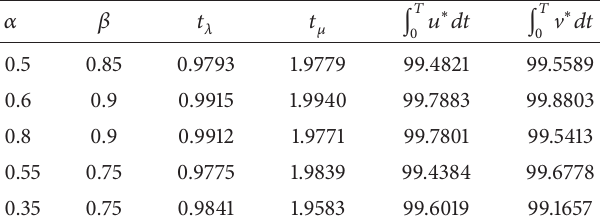
Figure 2: Changes of 𝐽(𝑢, V ) with the different reinforcement rate 𝑢 for 𝑋 .